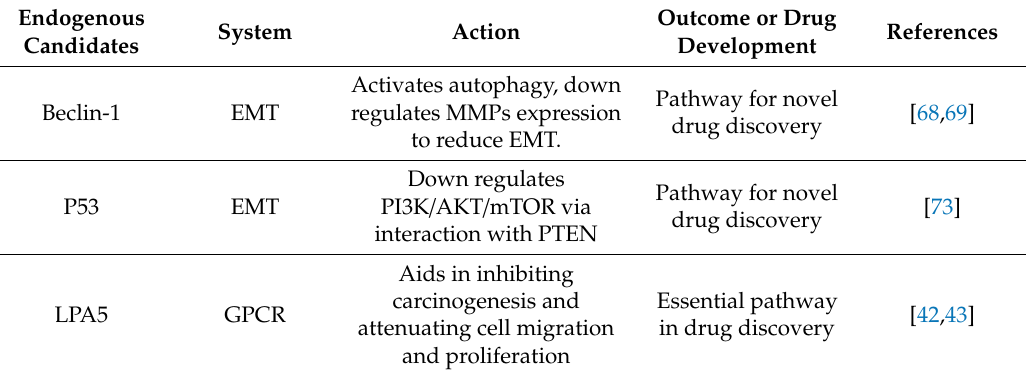
Table 1. Endogenous anti-cancer agents.